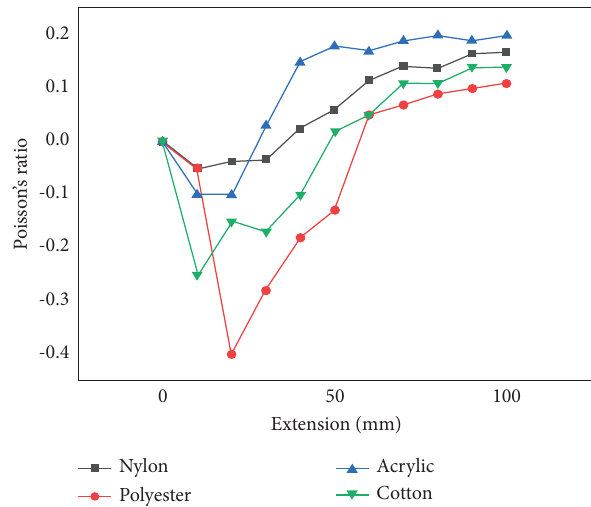
Figure 18: Negative Poisson’s ratio of line